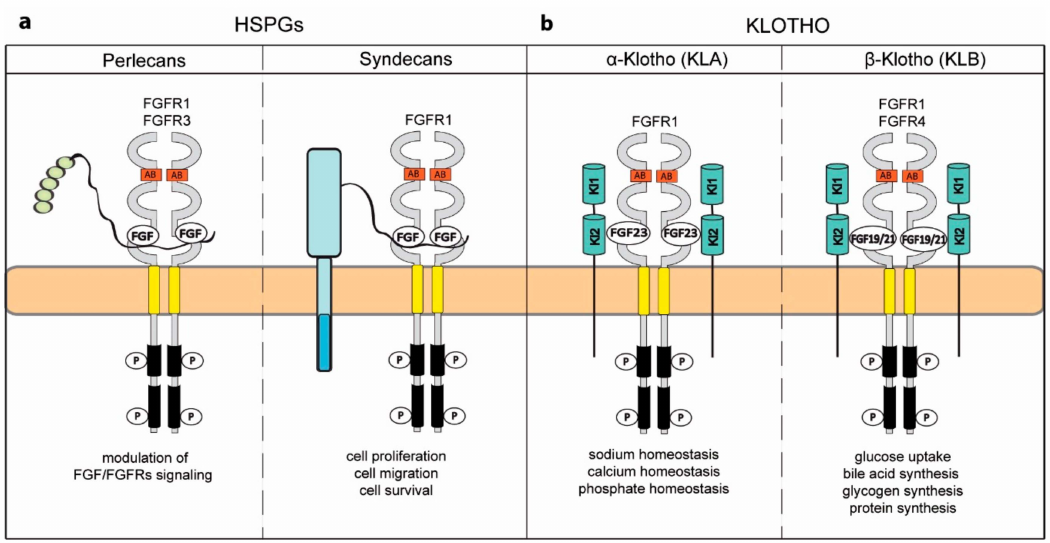
Figure 3. Involvement of coreceptors in the FGFRs signaling. ( a ) Heparan sulfate proteoglycans (HSPGs) provide polysaccharide chains that stabilize FGF-FGFR complexes and regulate availability of ligands. HSPGs are either integral membrane proteins (syndecans) or secreted glycoproteins (perlecans), which form ternary complexes with FGF-FGFR. ( b ) Klotho proteins α (KLA) and β (KLB) are necessary for FGF23 and FGF19 / FGF21 signaling,